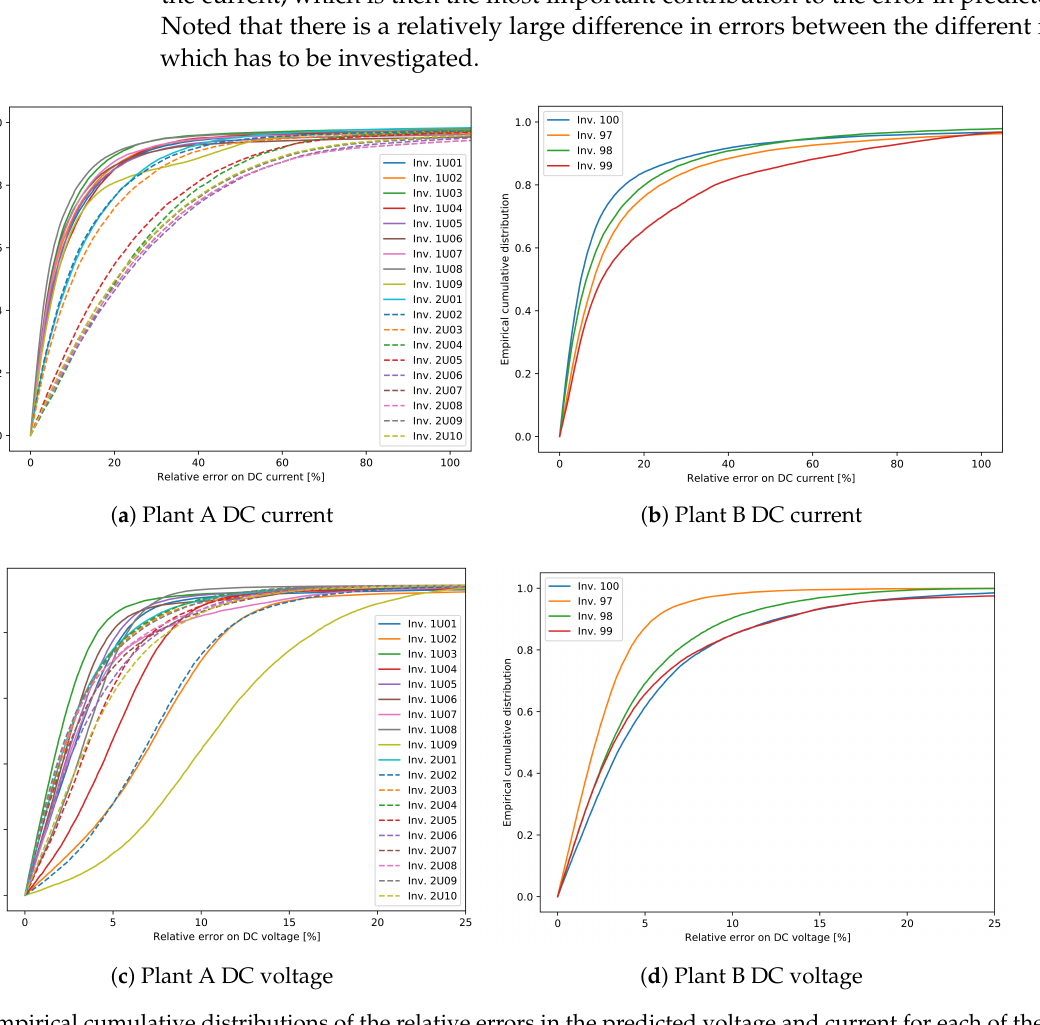
Figure 8. Empirical cumulative distributions of the relative errors in the predicted voltage and current for each of the two plants and each inverter on the test set. Only the points where the current is higher than 5% of the maximum measured inverter’s current are